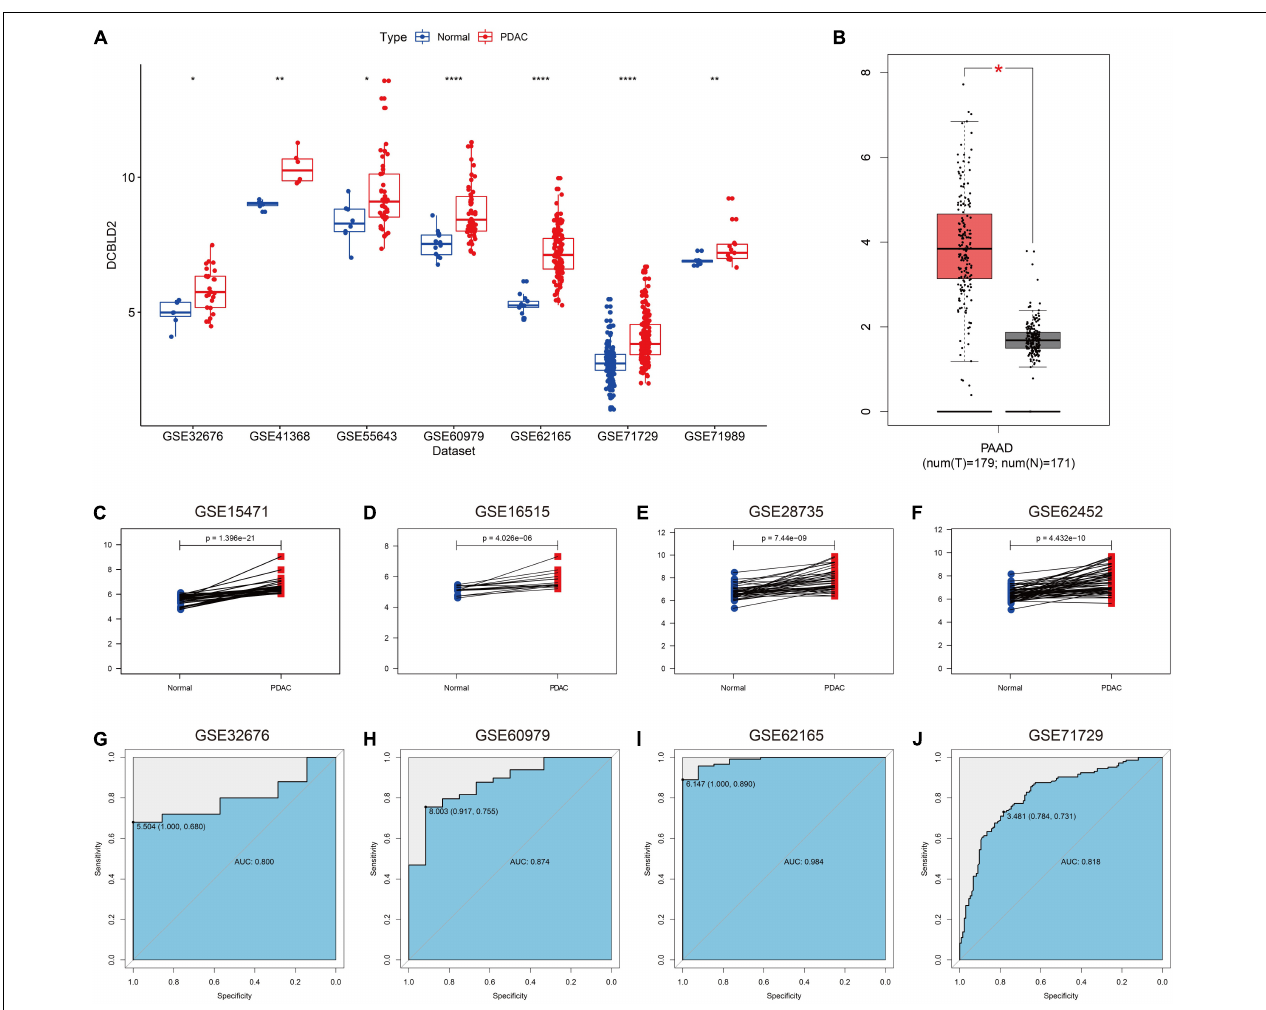
FIGURE 2 | Expression of DCBLD2 in PDAC tissues and its diagnostic value. (A) The expression of DCBLD2 in unpaired PDAC tissues and normal tissues in seven independent PDAC cohorts. (B) Expression profile of DCBLD2 based on the GEPIA database. (C–F) Expression pattern of DCBLD2 in PDAC tissues and matched adjacent normal tissues in four independent PDAC cohorts. (G–J) ROC curves illustrated the value of DCBLD2 in the diagnosis of PDAC in four independent PDAC cohorts. The statistical significance of differential expression was assessed by Wilcoxon test (* p < 0.05, ** p < 0.01 and **** p <